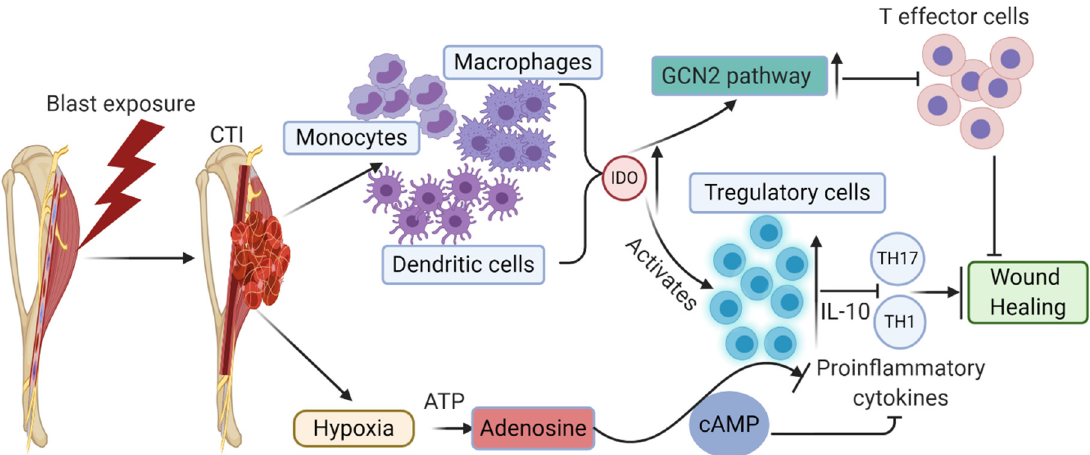
Figure 4. Stress-induced amino acid-sensitive pathway, GCN2 signaling is activated in CTI conditions at the very early stages, thus inducing Treg functions not necessary at that stage of wound healing, thus inhibiting/disrupting the natural course of the acute pro-inflammatory phase. Increased expression of Tregs at early stages delays wound healing through the GCN2